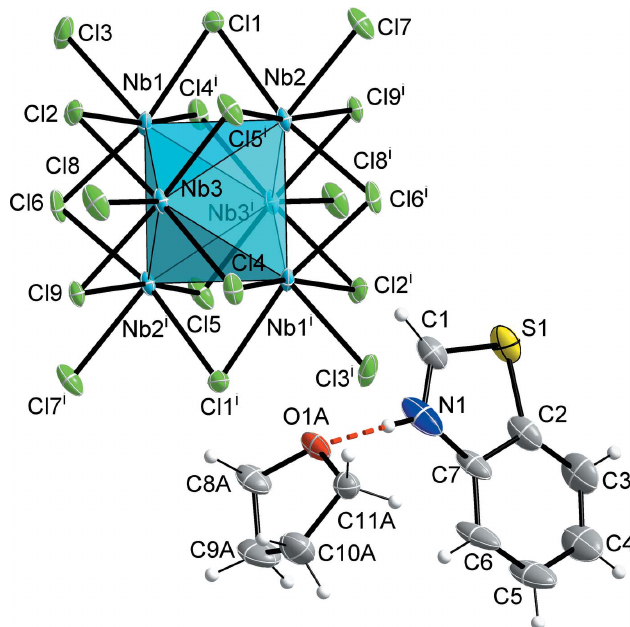
Figure 1 View of the structure of the niobium cluster anion, the benzothiazolium cation and the co-crystallized tetrahydrofuran molecule in crystals of (HBTh) 2 [Nb 6 Cl 18 ] (cid:2) 2THF with the atom-labelling scheme. Displacement ellipsoids are drawn at the 50% probability level. The dashed red line represents a hydrogen bond. The dashed red line represents a hydrogen bond. Symmetry code: (i) (cid:3) x , 1 (cid:3) y , 1 (cid:3) z .